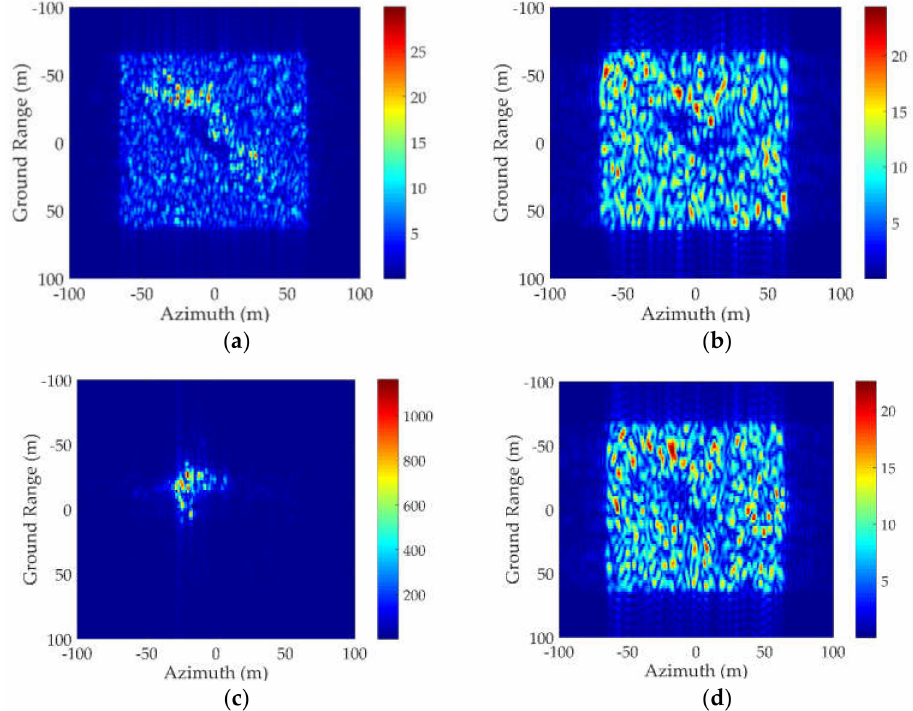
Figure 8. SAR images of composite ship–ocean scene with di ff erent parameters. ( a ) HH-pol, wind speed: 5 m / s, ship direction: 45 ◦ ( b ) VV-pol, wind speed: 5 m / s ship direction: 45 ◦ ( c ) HH-pol, wind speed: 5 m / s ship direction: 90 ◦ ( d ) HH-pol, wind speed: 10 m / s ship direction: 45 ◦